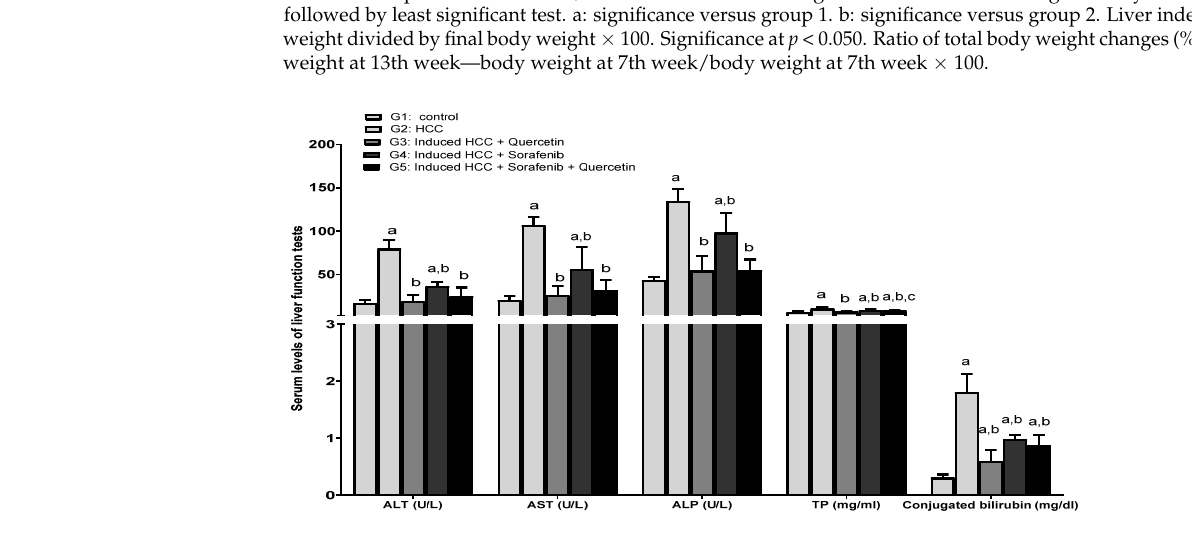
Figure 3. Liver enzyme levels in the serum of different studied groups. Data were expressed as mean +/ − standard deviation. Signi fi cance was made using one-way ANOVA test followed by least sig- nificant test. a: significance versus group 1. b: significance versus group 2; c: significance versus group 4. ALT: Alanine aminotransferase; AST: Aspartate aminotransferase; ALP: alkaline phospha- tase; TP: total protein. Significance at p < 0.050.